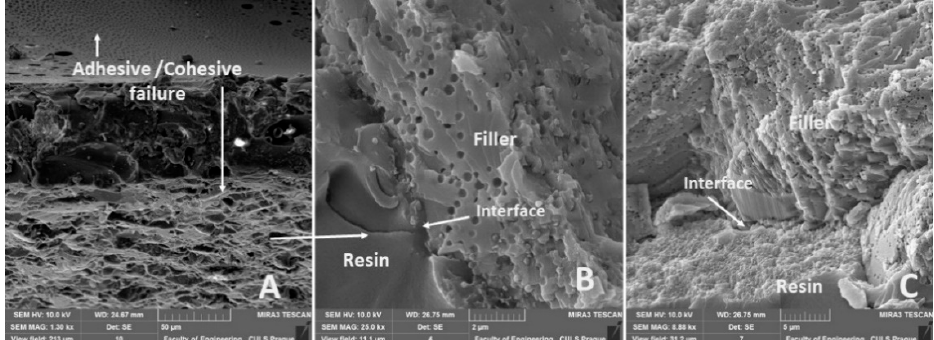
Figure 18. SEM images of fracture surface ABFE2: ( A ): adhesive/cohesive fracture surface of adhesive bond (MAG 1.30 k×, ( B ): detailed on adhesive/cohesive fracture surface and interface resin and filler and detailed view on filler surface (MAG 25.00 k×), ( C ): Cohesive fracture filler and detailed view on filler surface (MAG 8.88 k×).